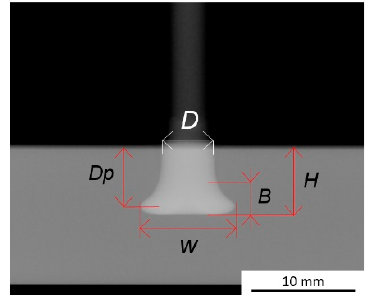
Figure 2. X-ray tomography joint formation measurements: rivet penetration depth (H); maximum width of the deformed rivet tip (W); depth until the maximum width of the rivet tip, or anchoring depth, (Dp); the height of the deformed rivet tip (B); and with original rivet diameter displayed (D).